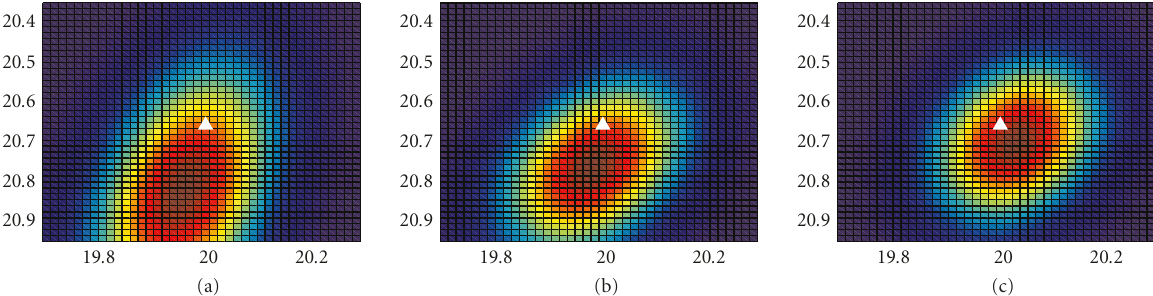
Figure 6: The approximated Gaussian belief after di ff erent number of TDOA values is integrated by the mobile agent. The white triangle at the centre of each subfigure is the true target position at time snapshot 15. (a) one TDOA is integrated; (b) two TDOAs are integrated; (c) three TDOAs are integrated. x -axis unit: meter; y -axis unit: meter.